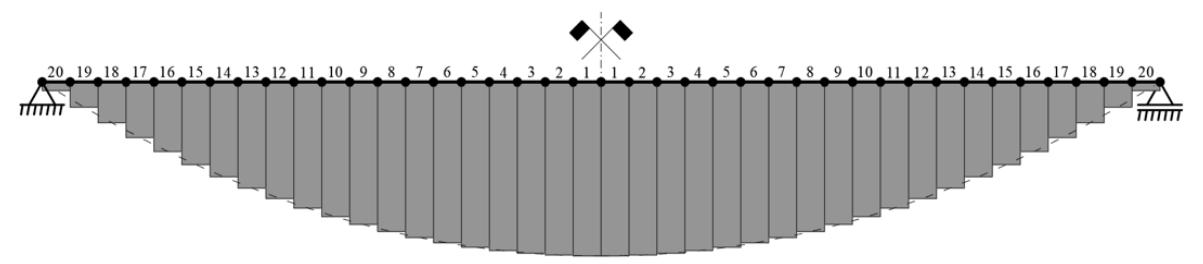
Figure 21: Stepped graph of bending moments with division of beam into fragments (dashed line shows actual shape of bending moments graph; dots on element’s longitudinal axis denote points of division of beam into fragments).